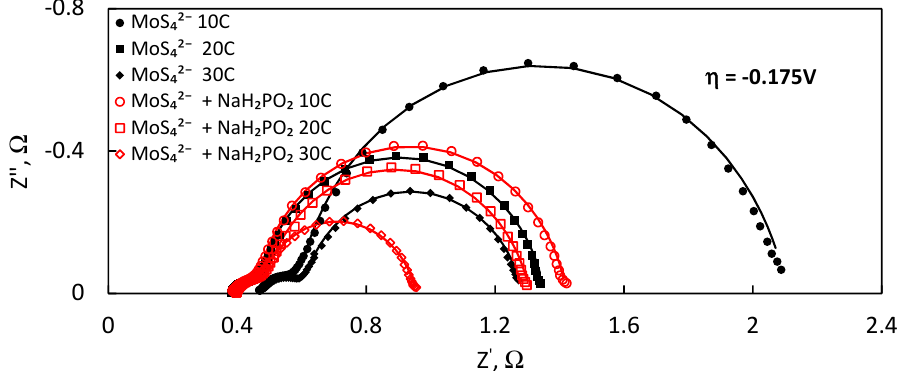
Figure 8. Nyguist plot of EIS for films, electrodeposited with and without NaH 2 PO 2 , for a different amount of charge. Points are experimental data, while lines represent fitting to EEC shown in Figure 7.